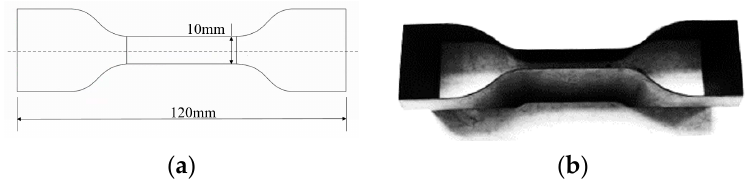
Figure 2. Sample size and dumbbell cutter ( a ) Sample size; ( b ) Dumbbell cutter.